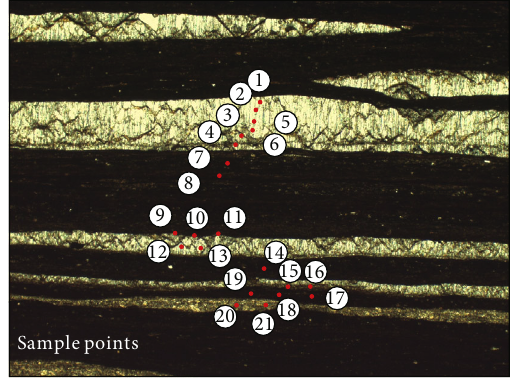
Figure 4: LA-ICP-MS point of laminated argillaceous sparry